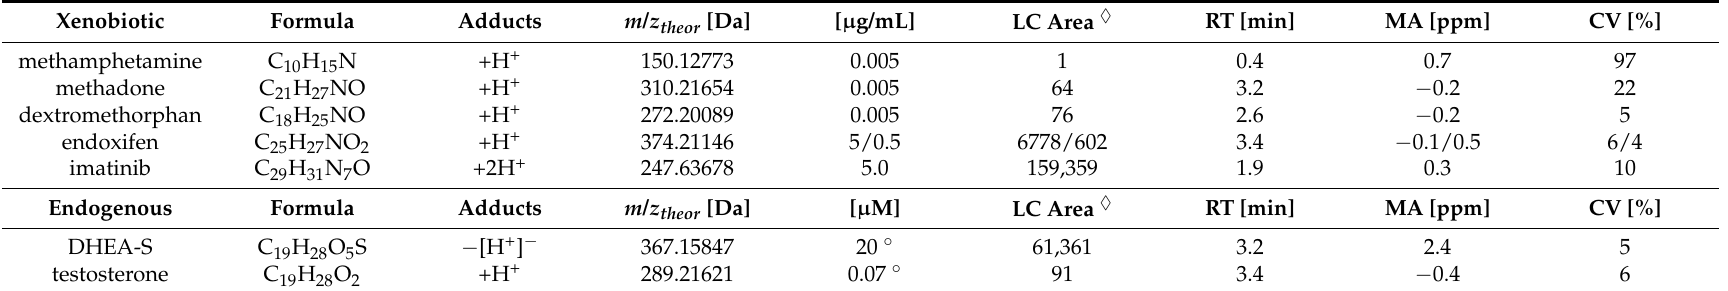
Table 1. Chemical information on the spiked compounds